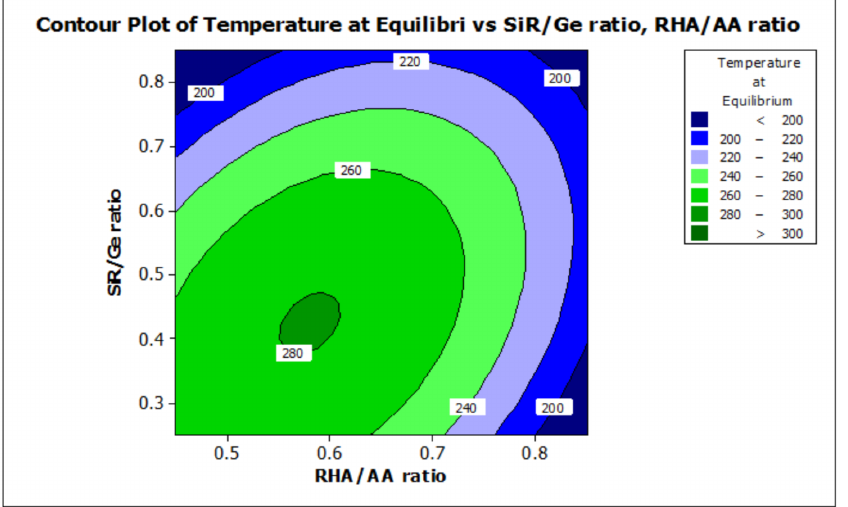
Figure 7. Contour plot for the effect of RHA/AA and SiR/Ge ratios on the temperature at equilibrium properties of RHA/SiR-based binary blended geopolymer coating composite.